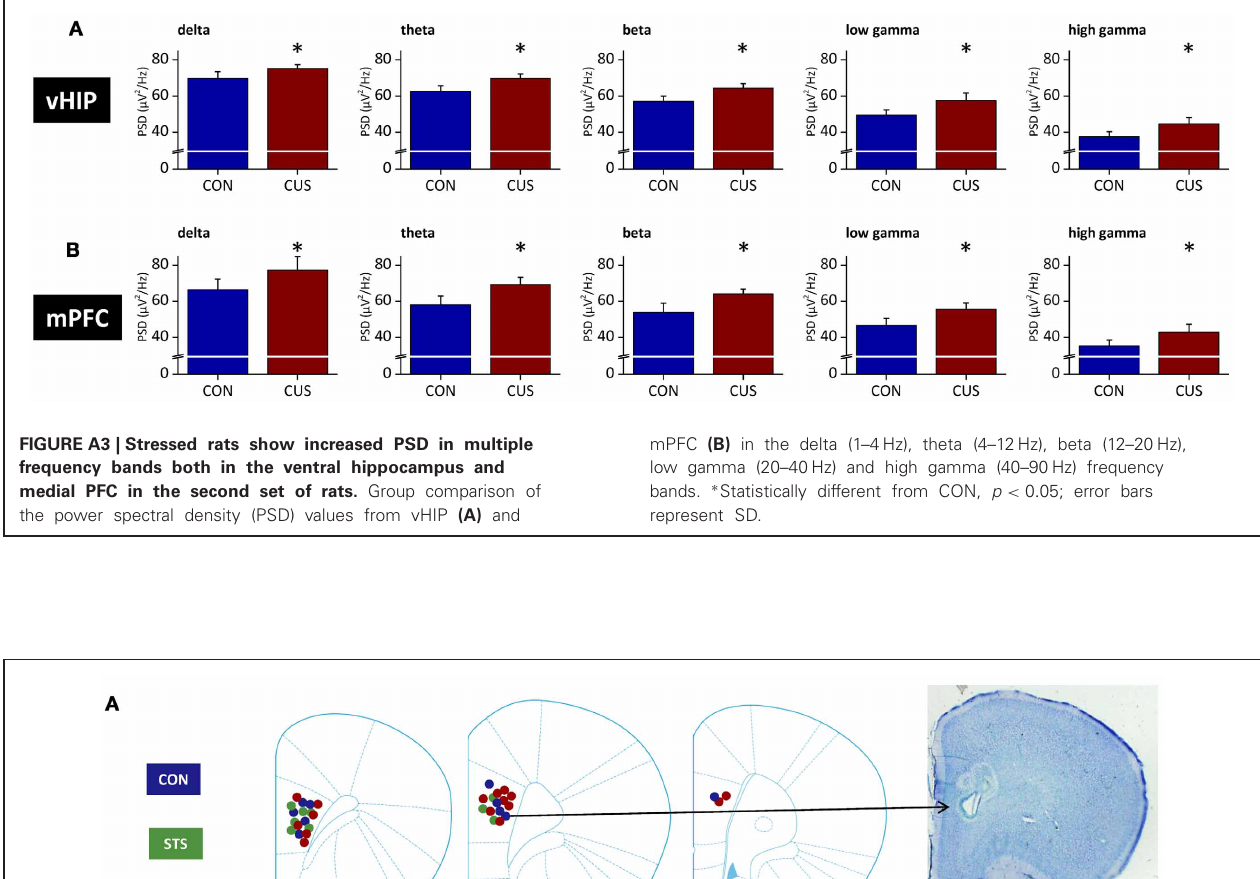
mPFC (B) in the delta (1–4Hz), theta (4–12Hz), beta (12–20Hz), low gamma (20–40Hz) and high gamma (40–90Hz) frequency bands. ∗ Statistically different from CON, p < 0 . 05; error bars represent SD.